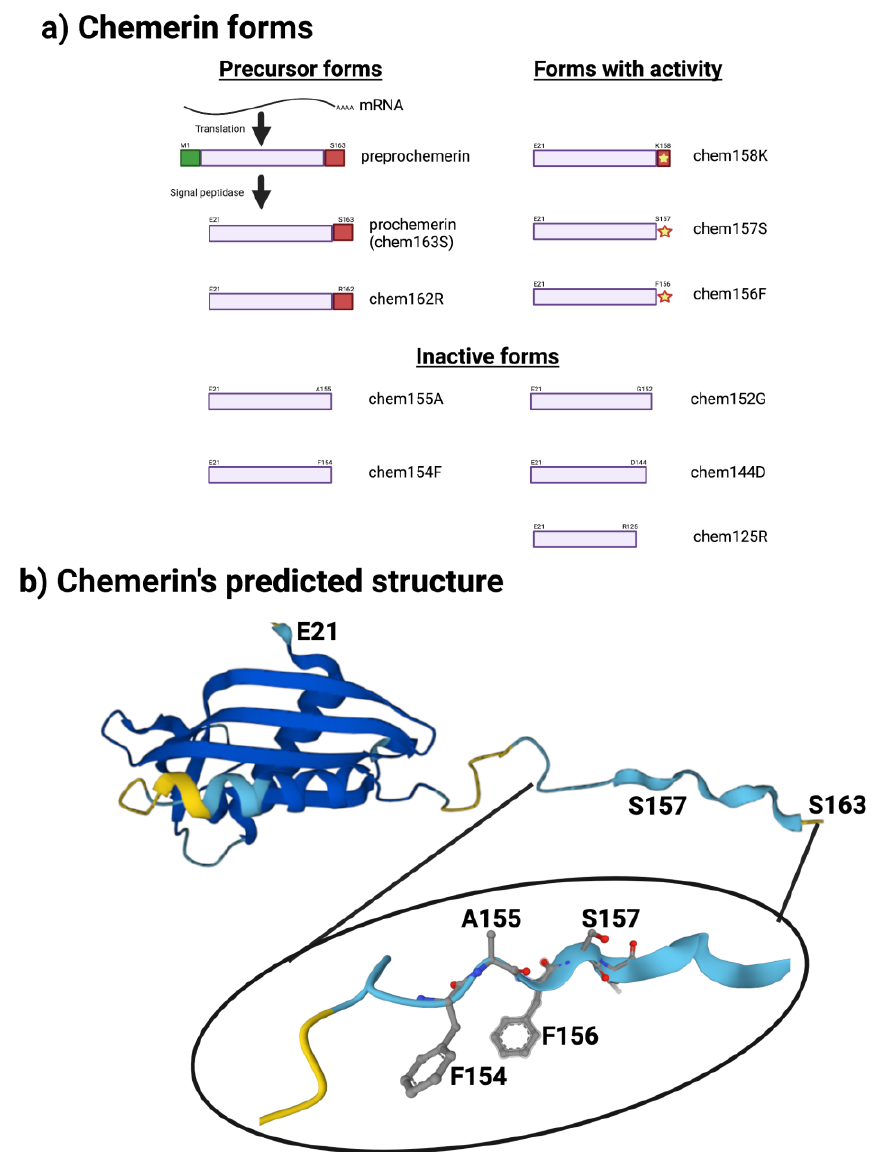
Figure 1. Chemerin forms and chemerin’s predicted structure. Created with BioRender.com. ( a ) Chemerin forms that have been identified in biopsy samples are grouped into those that are precursors with no intrinsic activity but can be activated by appropriate proteolysis, those that are active, and those are inactive. ( b ) The structure of chemerin predicted by AlphaFold [15,16] with the darker blue colors representing higher per-residue confidence in the prediction with a magnification of the C-terminal